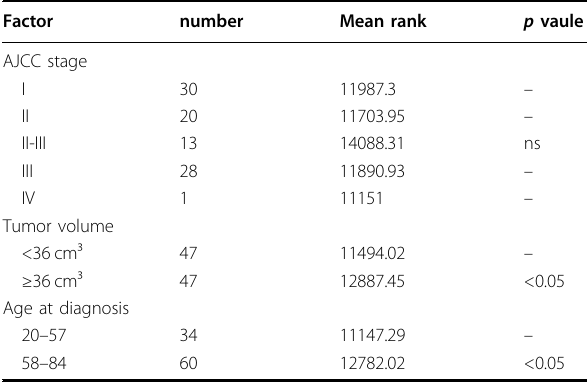
the older patients and the bigger tumors.